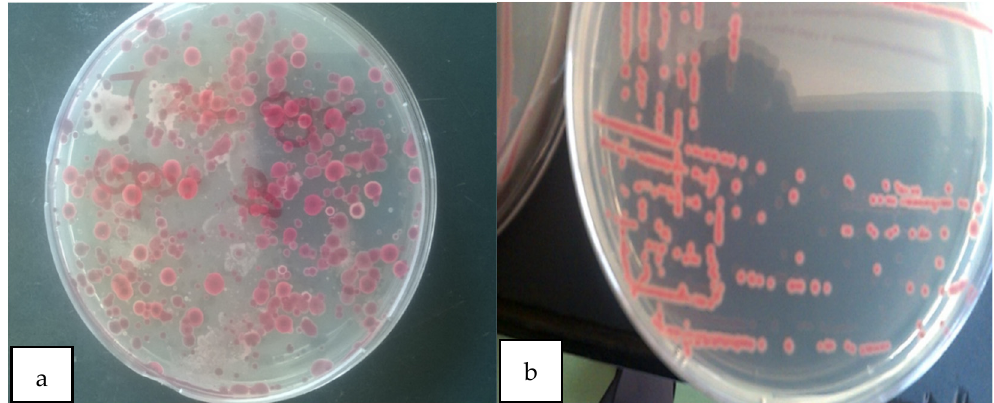
Figure 1. ( a ) Mixed colonies of virulent and avirulent R. solanacearum ; ( b ) pure colonies of virulent R solanacearum. The observation of Gram staining reaction done on the colonies of R. solanacearum isolates showed pink small rod-shaped cells under the microscope at ×100 magnification (Table 1). These Gram staining reaction observations are in line with those reported by